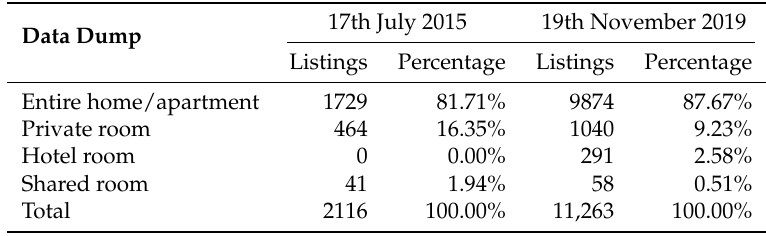
Table 2. Listing types.